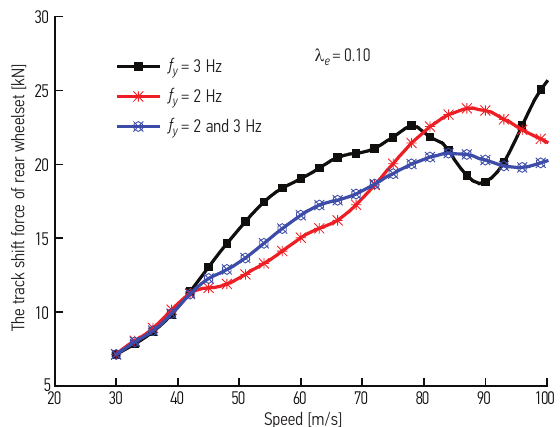
Fig. 13. The track shift forces with the different suspension frequencies at λ e is 0.1